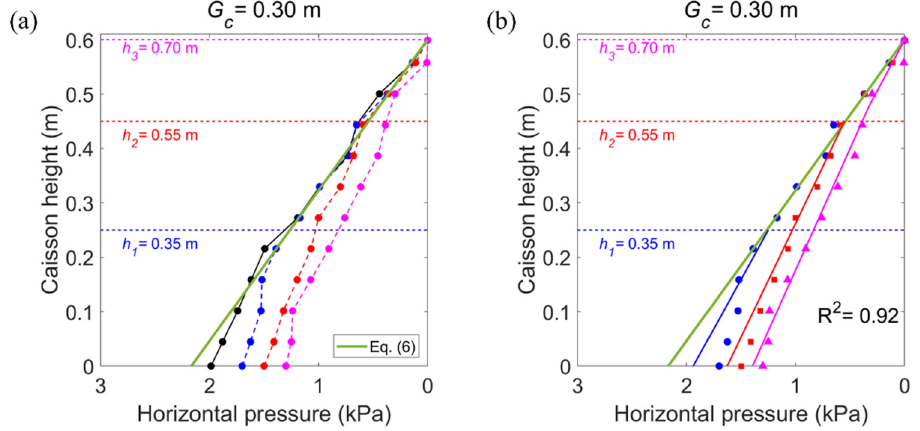
Figure 13. ( a ) Measured horizontal pressure in three different conditions of water level; ( b ) comparison with the pressure measured with Equation (6) by taking account of the buoyancy effect due to the submergence of the stones.